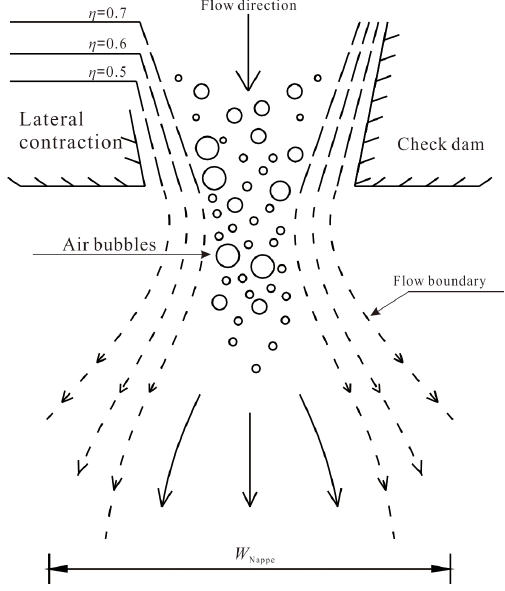
Figure 8. The transverse expansion of a debris flow nappe at differ- ent lateral contraction ratios. Table 2. The energy dissipation rates at different contraction ratios.